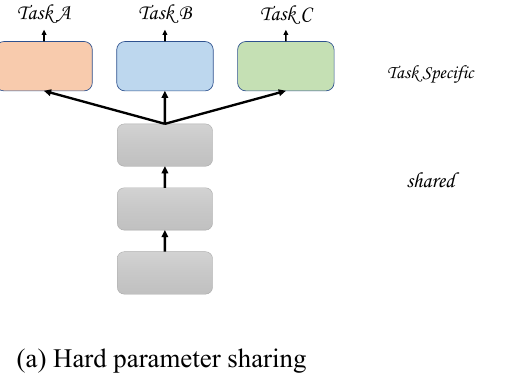
Figure 5. Hard parameter sharing and Soft parameter